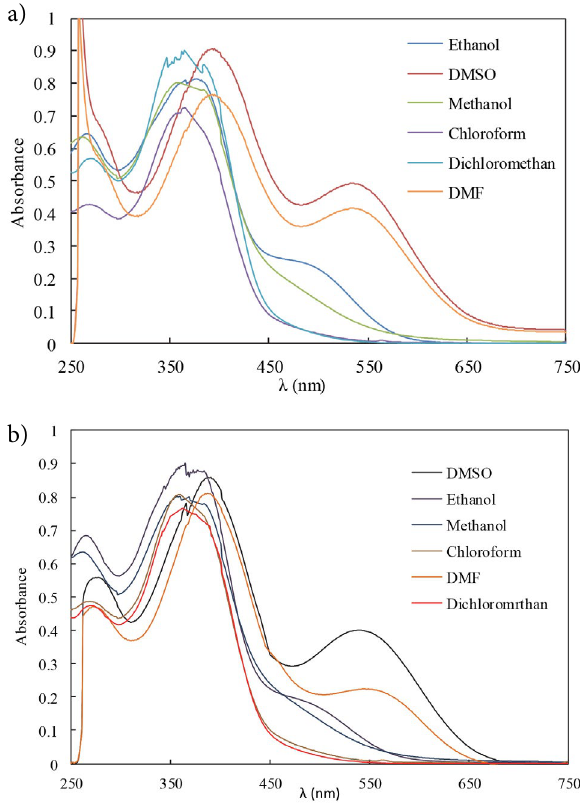
Fig. 4 : UV-vis spectra of azo Schiff-bases 1 (a) and 2 (b) in various solvents (~10 -4 M)